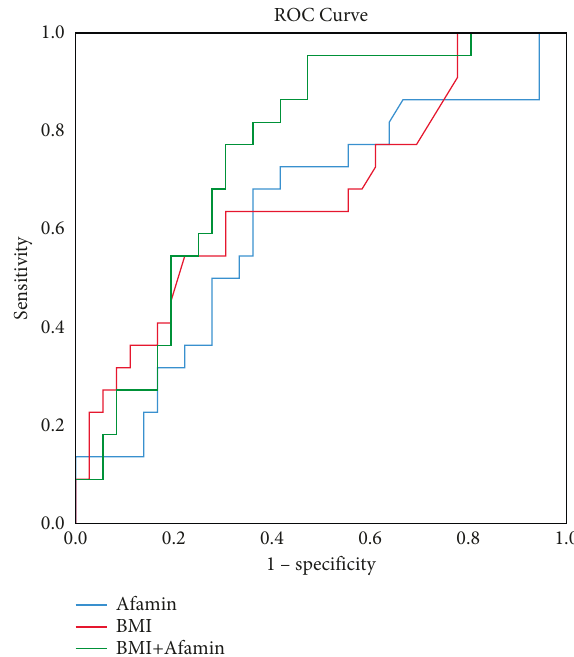
Figure 4: The receiver operating characteristic (ROC) analysis of afamin, body mass index (BMI), and BMI plus afamin for detecting NAFLD in biopsy-proven participants. The ROC curves for afamin, the BMI, and afamin plus the BMI are shown. The area under the curve (AUC) of afamin was 0.628. The area under the curve (AUC) of the BMI was 0.670. The area under the curve (AUC) of afamin plus the BMI was